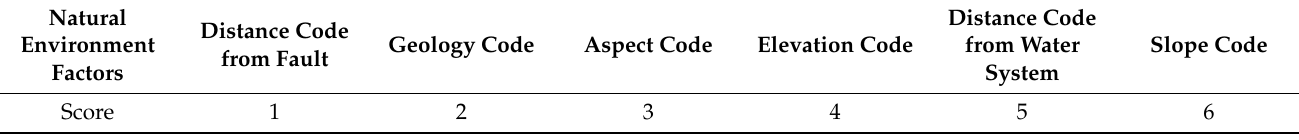
Table 4. Impact scores of natural environmental factors on landslide